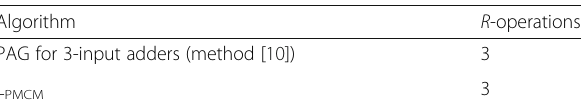
Table 9 Resulting R -operations for Example 5 using n = 3 input adders Algorithm